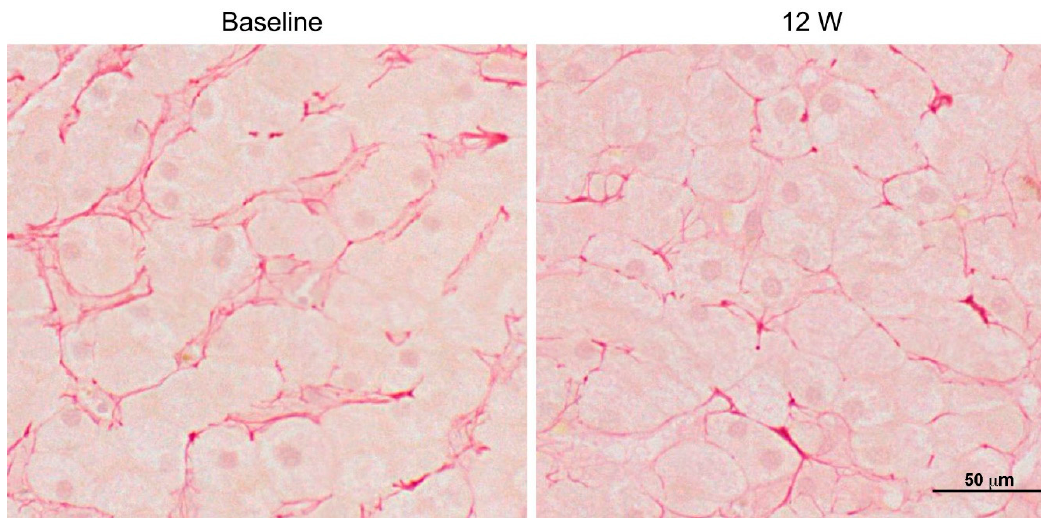
Figure 4. Histopathology of hepatic lobules stained with Sirius Red (400×). Liver biopsy sample from patient C2-03 (40 mg/m 2 /day PRI-724 in a CP class B cohort) at 12-weeks post-PRI-724 treatment. Scale bar = 50 µ